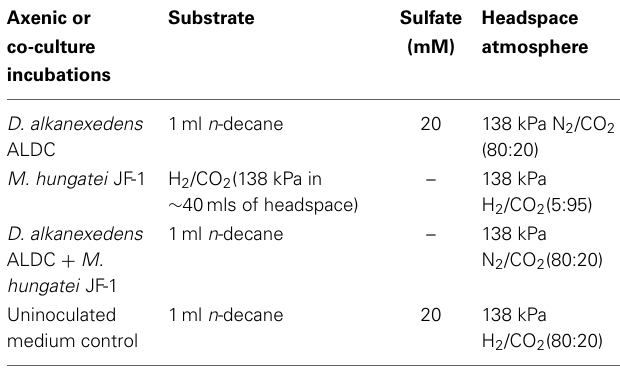
Table 1 | Substrate, sulfate, and headspace amendments for hydrocarbon degrading